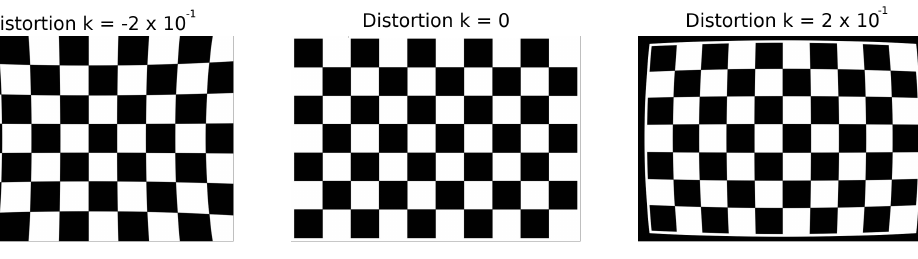
Figure A2. Reference distortion used in the paper, visualized by a checkerboard pattern. From left to right: Pincushion distortion, no distortion, barrel distortion.